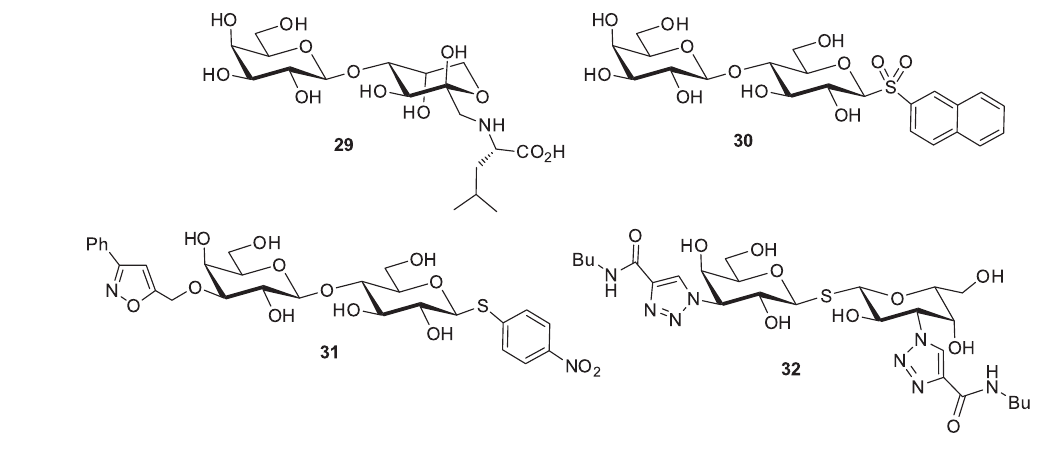
FIGURE 11 – Synthetic monovalent glycomimetics acting as selective galectin inhibitors.